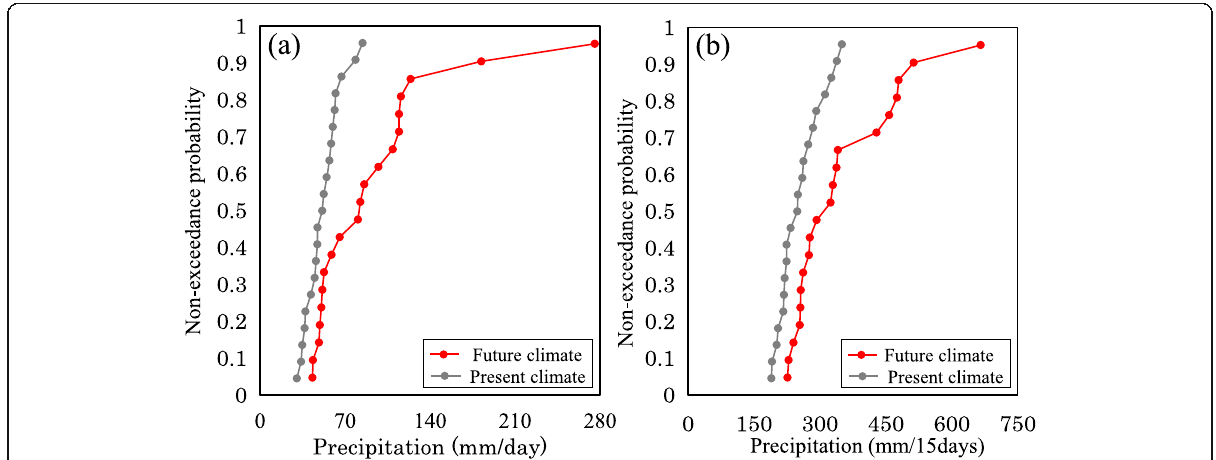
Fig. 10 Projected CDF of present and future NHRCM annual maximum a daily and b 15-day rainfall